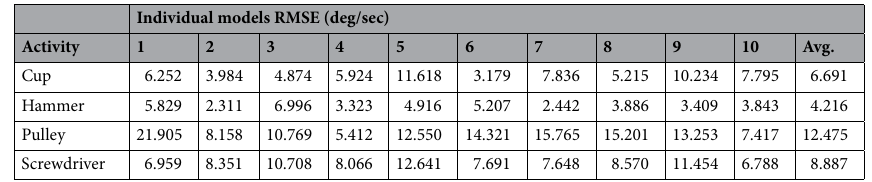
˙ θ ˙ θ R ) angular velocity of M ) and predicted (